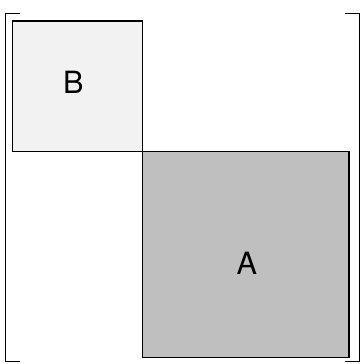
Figure 3. Formation of global matrix coefficients in mixed time partitioning methods (block matrix where B refers to cast domain, A refers to other